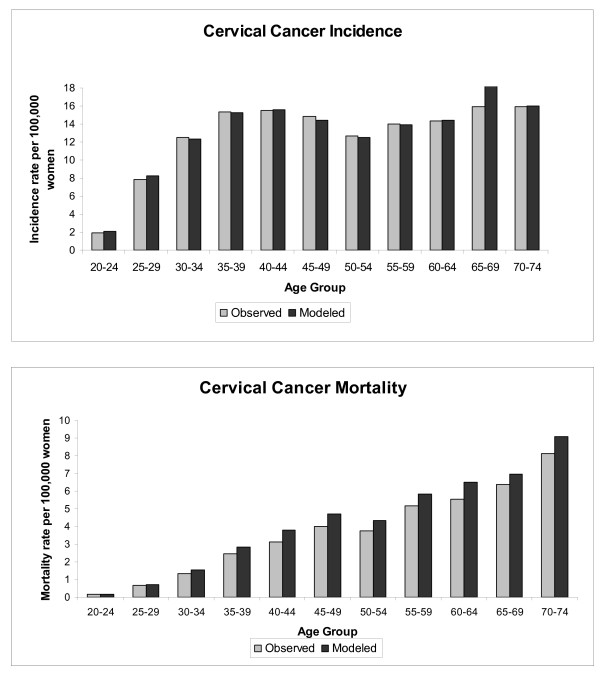
Model Calibration: Observed vs. model predicted cases and deaths. Note: The total number of observed vs. modeled cervical cancer cases and deaths were tested for differences using a Chisquare test for significance and evaluated at the p = 0.05 level. No statistically significant differences were found.